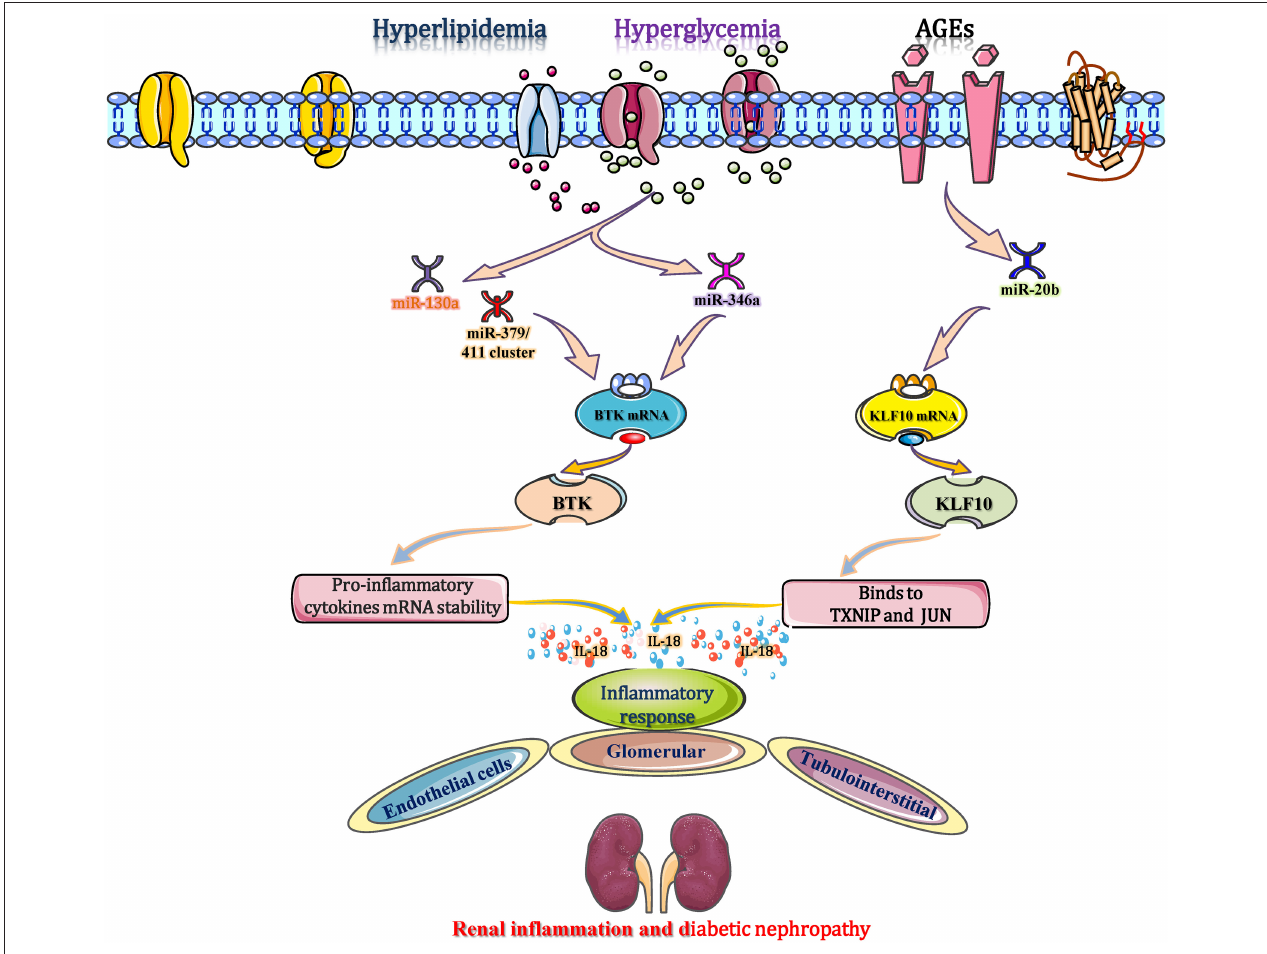
FIGURE 6 | miRNAs interfere with inflammation in DN by affecting interleukin 18 secretion. During the diabetic process, obesity and hyperglycaemia reduce the expression of miR-346 in the renal cortex. miR-346 binds to the 3 ′ -UTR of Bruton’s tyrosine kinase (Btk) mRNA to inhibit its transcription, leading to the downregulation of Btk protein. Therefore, the increased Btk stabilizes the mRNA of IL-18 to ensure its secretion and ultimately promotes the inflammatory response in diabetic kidneys. Moreover, high glucose and AGEs down-regulate the expression of miR-15a, miR-20b, and miR-181c. Among them, miR-20b targets the KLF10 gene to promote KLF10 mRNA transcription, which then binds to IL18 to mediate and accelerate the inflammatory response in renal endothelial cells. miR-130a and the miR-379/411 cluster elevate IL-18 to promote the release of IFN- γ , resulting in the production of other inflammatory cytokines, such as ICAM-1, and promoting endothelial cell apoptosis. These alterations are associated with glomerular and tubulointerstitial inflammation and eventually contribute to DN progression. BTK, bruton’s tyrosine kinase; KLF10, kruppel-like factor 10; TXNIP, thioredoxin interaction